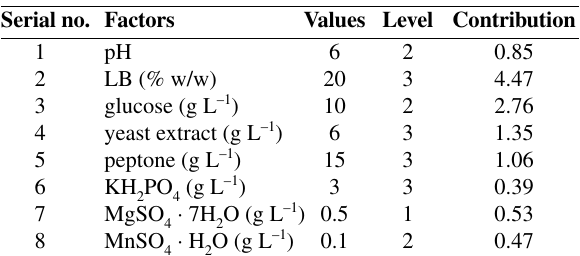
Table 5: Optimum culture conditions and their contribution Serial no. Factors